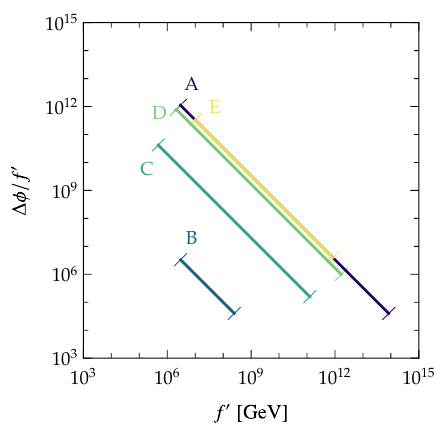
Figure 10 . Ratio of the total (cid:12)eld excursion (cid:1) (cid:30) (cid:24) (cid:3) =g 0 over the decay constant f 0 , for the (cid:12)ve benchmarks de(cid:12)ned in eq. (5.28). The lines are cut at the allowed values of f 0